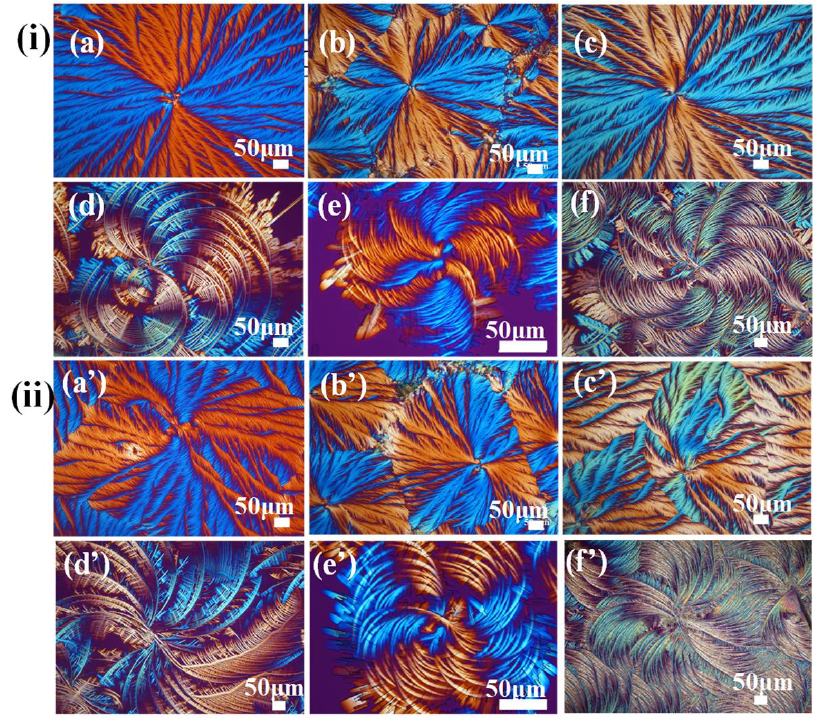
Figure 6. POM graphs of ( i ) (R)-MA/PVPh (50/50) and ( ii ) (S)-MA/PVPh (50/50) blends crystallized at ( a – c , a’ – c’ ) T c = 45 °C and ( d – f , d’ – f’ ) T c = 65 °C. The film thickness is ( a , d ) 2–5; ( b , e ) 10–20; and ( c , f ) 25–30 µm.